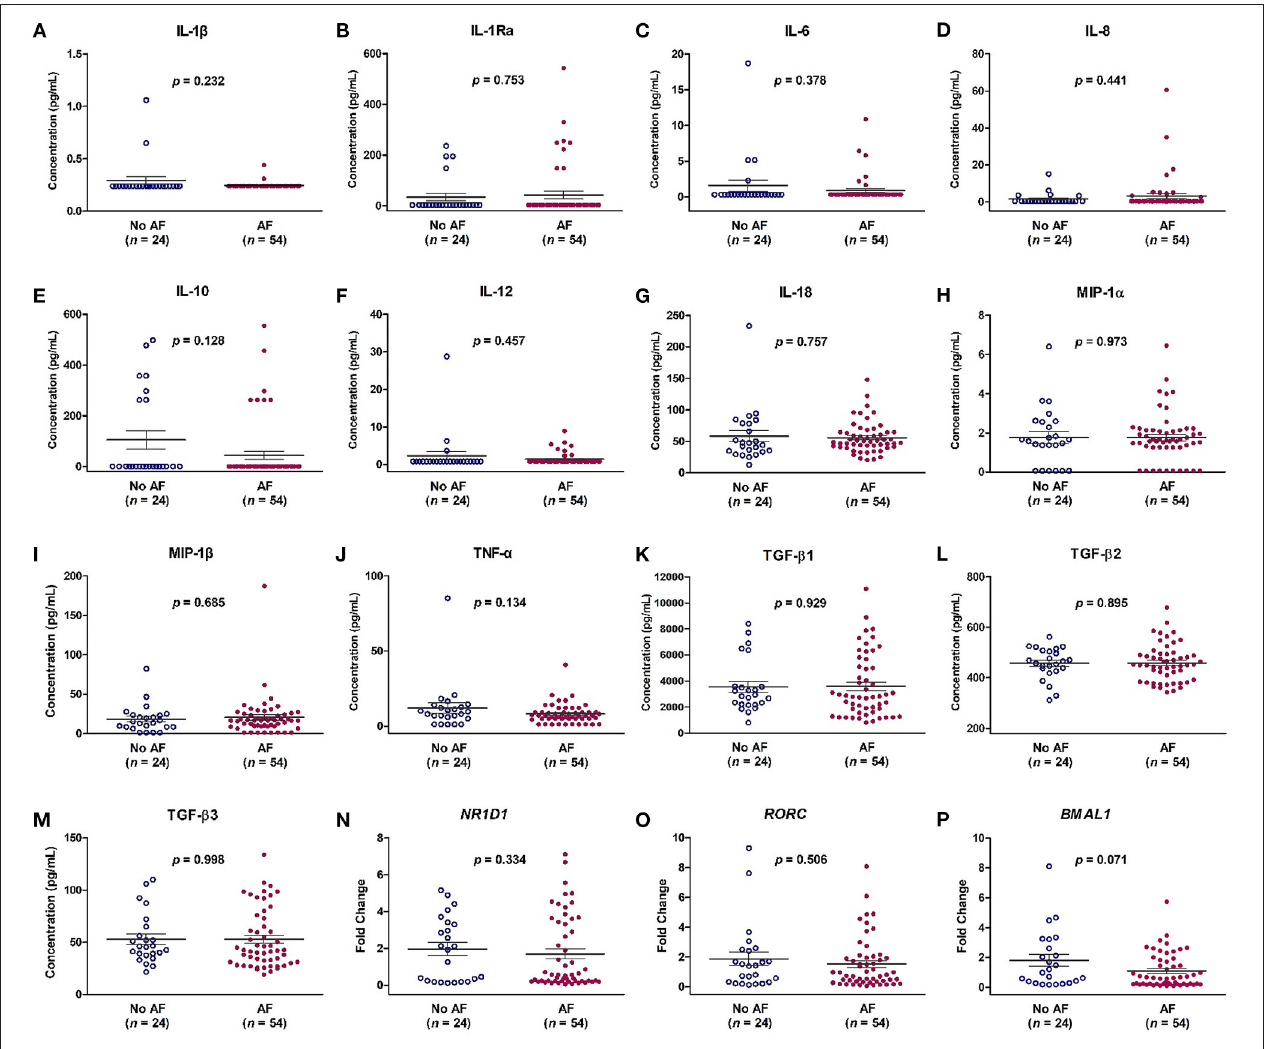
FIGURE 1 | Expression levels of cytokines (A–M) and mRNA expression of NR1D1 (N) , RORC (O) , and BMAL1 (P) in patients with and without atrial fibrillation (AF). The y-axis represents the expression of cytokines or the fold change of the gene expression level in patients with AF compared to patients without AF. The p -value analyzed by Student’s t -test indicates statistical significance as evaluated between patients with ( n = 54) and without AF ( n = 24). IL, interleukin; MIP-1 α , macrophage inflammatory protein-1 alpha; TGF- β , transforming growth factor beta.